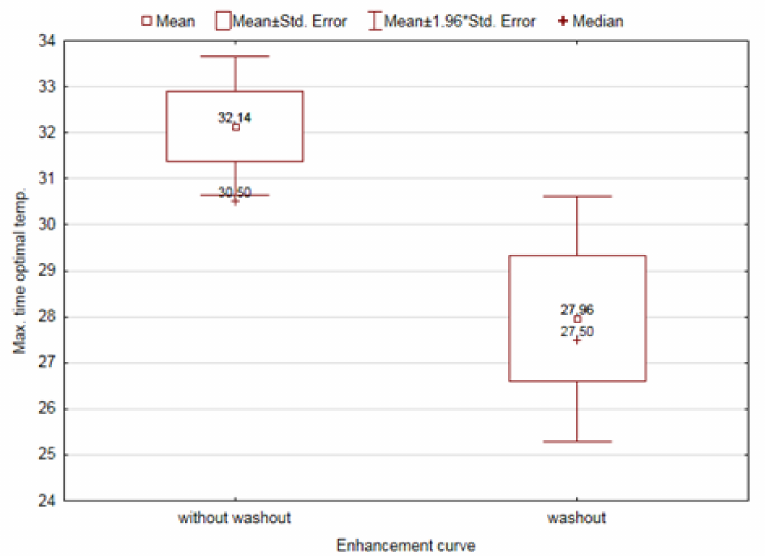
Figure 6. The effect of the distribution of the enhancement curve on the maximum time of optimal temperature.